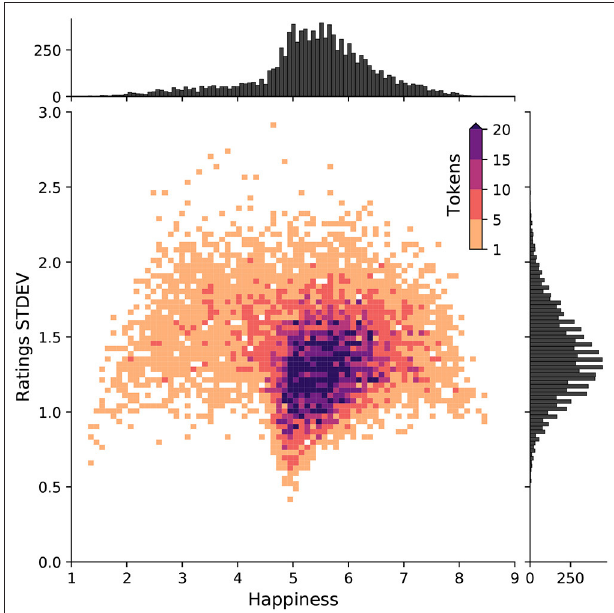
FIGURE 1 | Emotional valence of words and uncertainty in human ratings of lexical polarity. A 2D histogram of happiness h avg and standard deviation of human ratings for each word in the labMT dataset. Happiness is defined on a continuous scale from 1 to 9, where 1 is the least happy and 9 is the most. Words with a score between 4 and 6 are considered neutral. While the vast majority of words are neutral, there is a positive bias in human language ( Dodds et al., 2015 ). The average standard deviation of human ratings for estimating the emotional valence of words in the labMT dataset is 1.38.